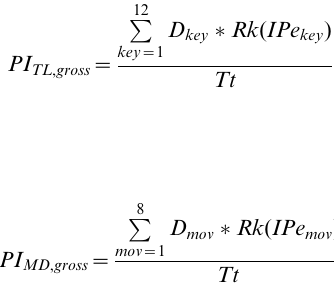
Thumb Movement Thumb Effective